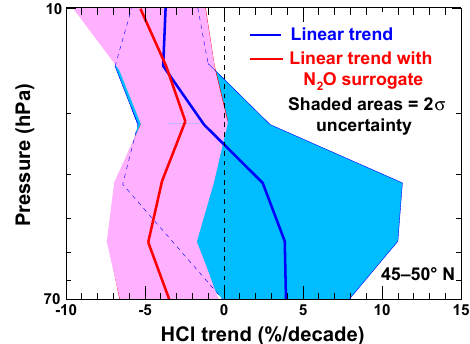
Figure 5. Linear trend in HCl concentrations determined from MLS measurements between 70 and 10hPa (approximately 20 to 30km altitude) for the latitude band of 45–50 ◦ N. The blue line is the trend determined from the raw deseasonalized data. The red curve is the trend determined while including the N 2 O time series as an explana- tory variable. The shaded areas represent 2 σ uncertainties for